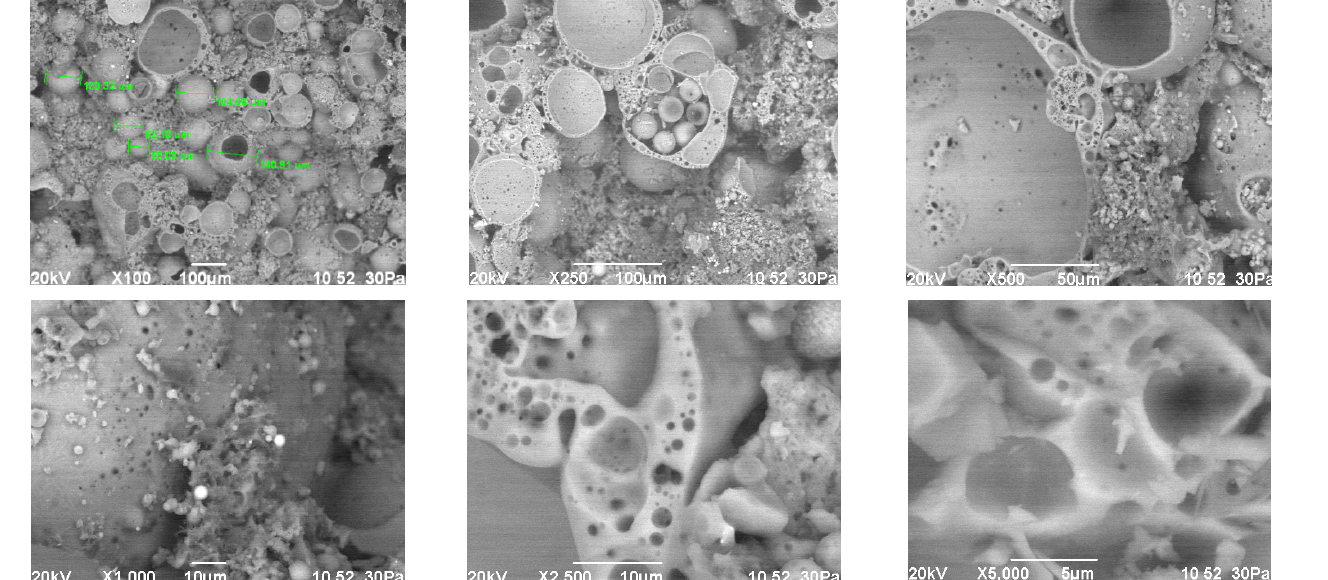
Figure 9. The microstructure of the liquid glass binder (mixture 39), fired at 350 °C. Table 7. Composition and properties of liquid glass binders.